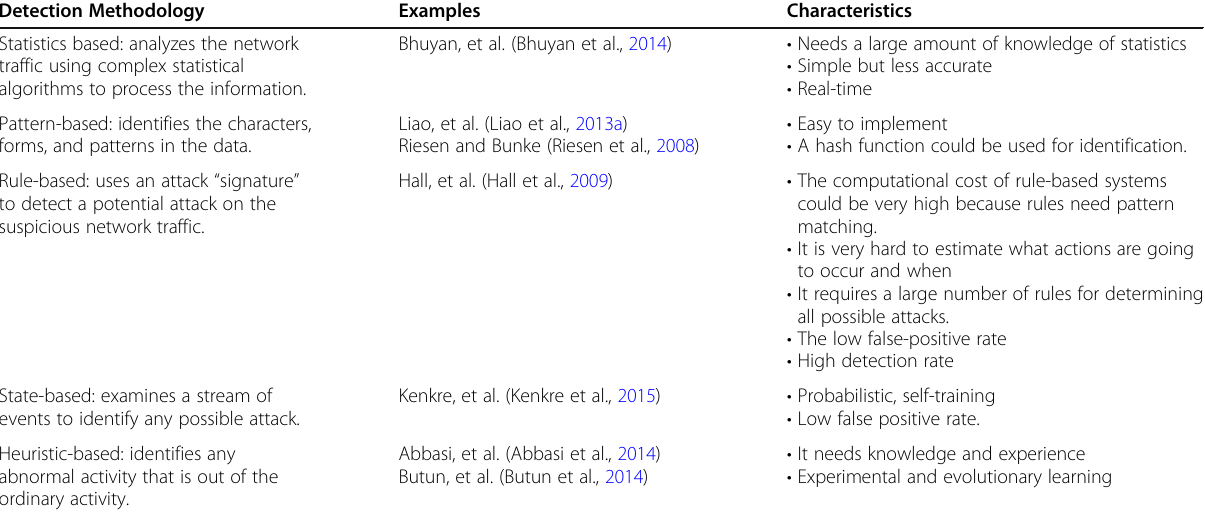
Table 3 Detection methodology characteristics for IoT IDS Detection